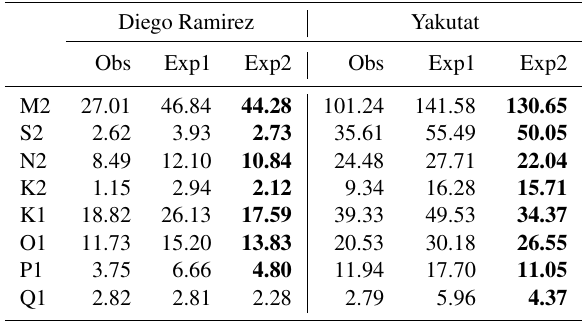
Table 2. The amplitudes of the eight tidal constituents during the observation (Obs), Exp1, and Exp2 at the Diego Ramirez Islands (56.56 ◦ S, 68.67 ◦ W) and Yakutat (59.54 ◦ N, 139.73 ◦ W). The ob- servation is from WOCE (Ponchaut et al., 2001); the units are cen- timeters. The better amplitude in Exp2 relative to Exp1 is marked in bold. Diego Ramirez